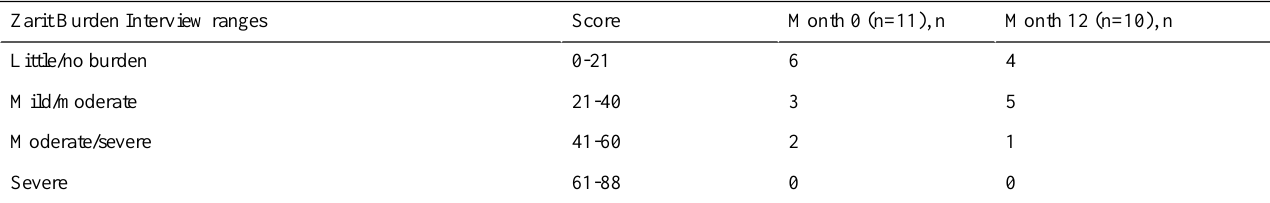
Table 18. Number of caregivers in each Zarit Burden Interview range group at months 0 and 12.